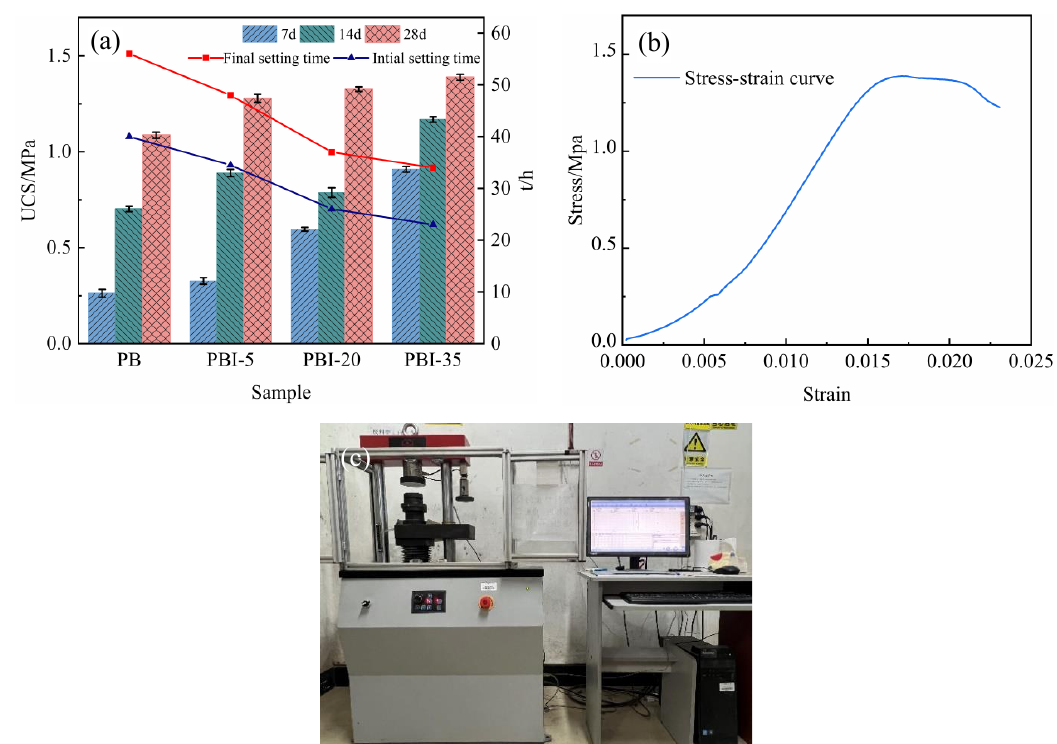
Figure 10. ( a ) UCS and setting time changes of backfill with different amounts of ITs; ( b ) Stress–strain curve of PBI-35 (28 d); ( c ) Servo pressure testing machine for UCS.